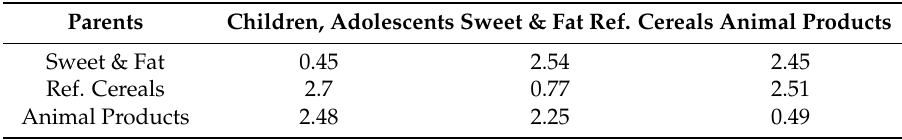
Table A1. Cross-tabulation of Euclidean distances between the cluster means of children and